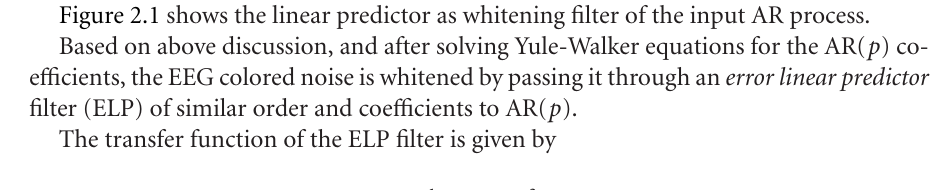
If one rearranges (2.5)